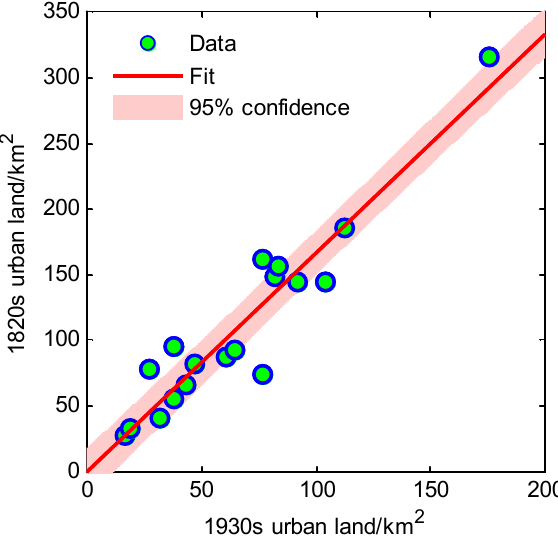
Figure 15. Scatter plot of 1930s urban land data and 1820s urban land data.